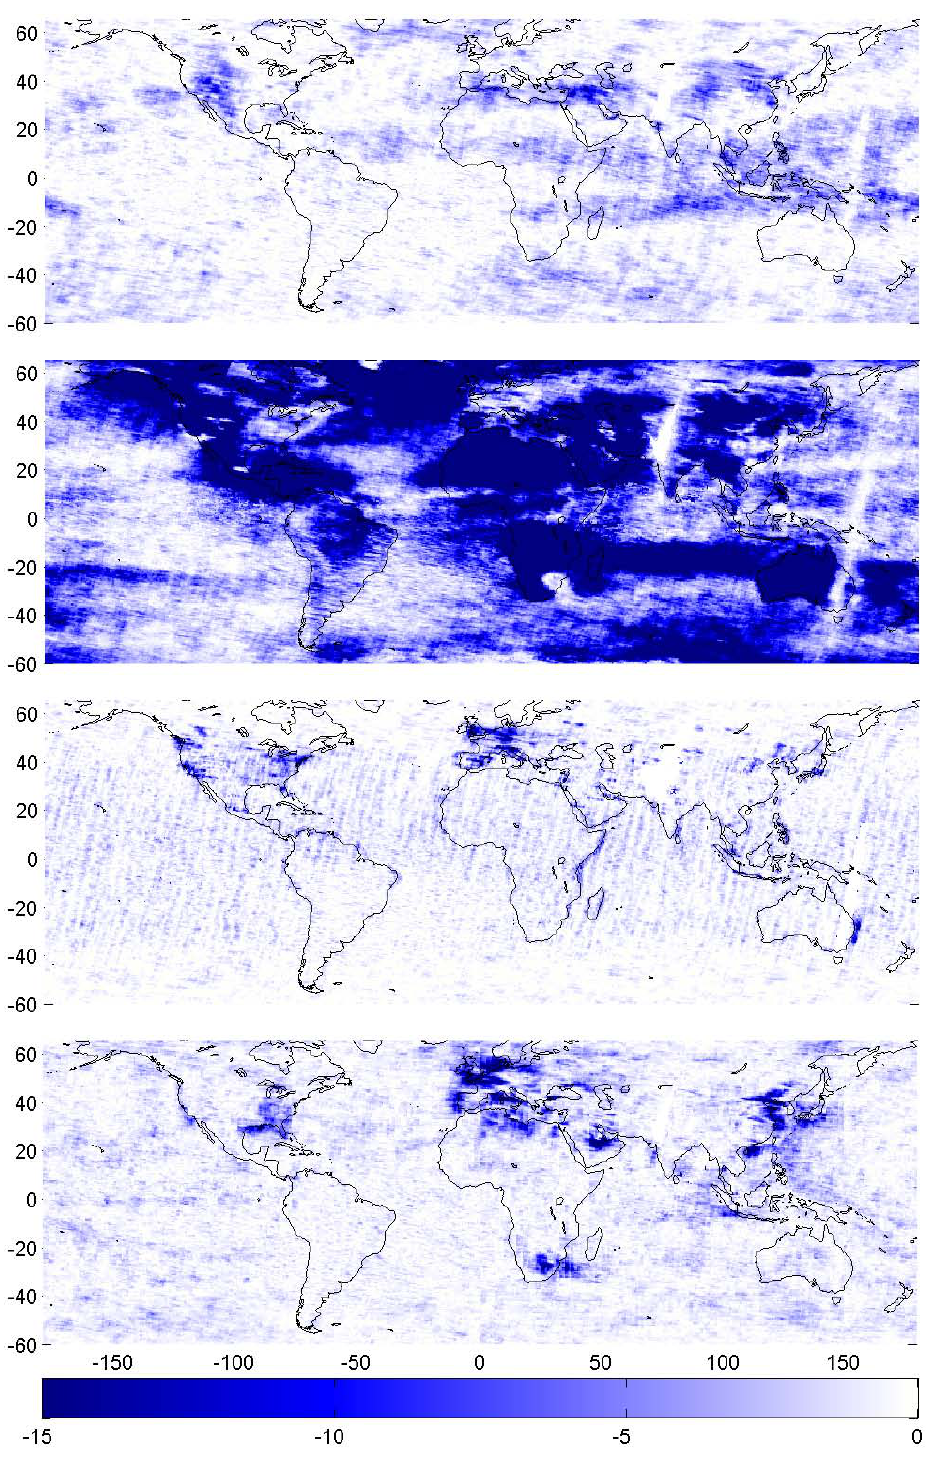
Fig. 3. The significance (log10 of the p-value) of the different GAM terms, i.e. trend, annual cycle, weekly cycle, and wind component (from top). Dark blue areas are affected significantly by the respective